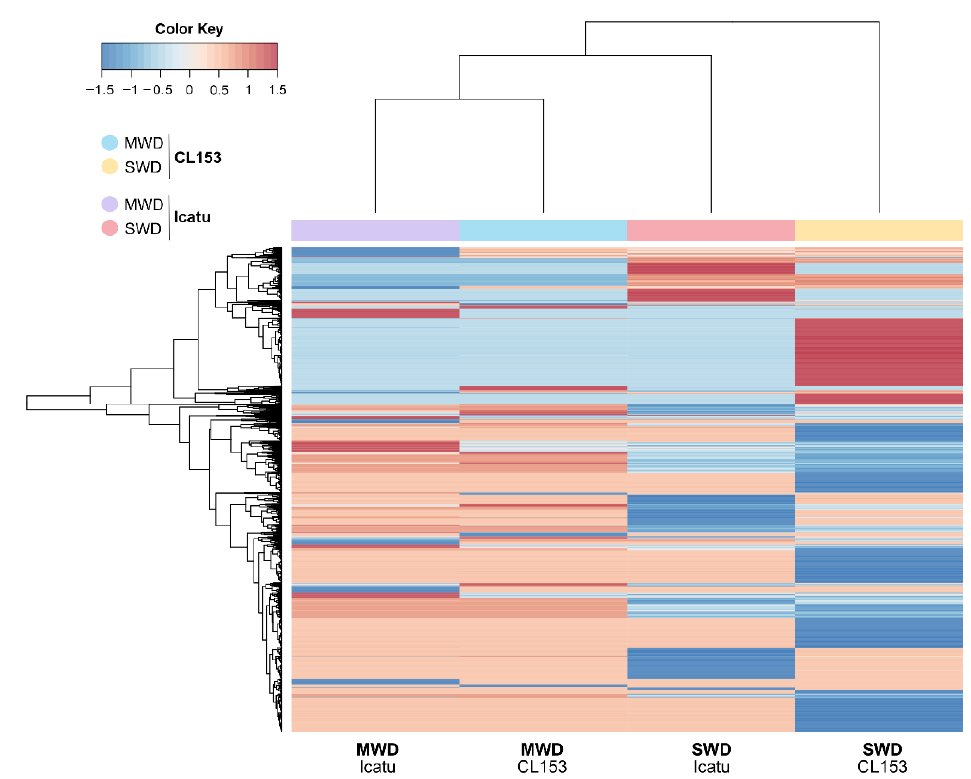
Figure 3. Clustered heat maps and dendrograms of the normalized log2 fold change (FC) visualizing the expression of significant (FDR < 0.01) treatment-specific differentially expressed genes (DEGs) considering the effect of moderate water deficit (MWD) and severe water deficit (SWD) conditions compared to well-watered plants (WW) in Coffea arabica cv. Icatu (Icatu) and C. canephora cv. Conilon Clone CL153 (CL153) plants. Values were scaled by row using Z-scores. Hot colors represent up- regulated DEGs, and cold colors represent down-regulated DEGs. Column color labels represent water treatments (colors of treatments follow Figure 1).